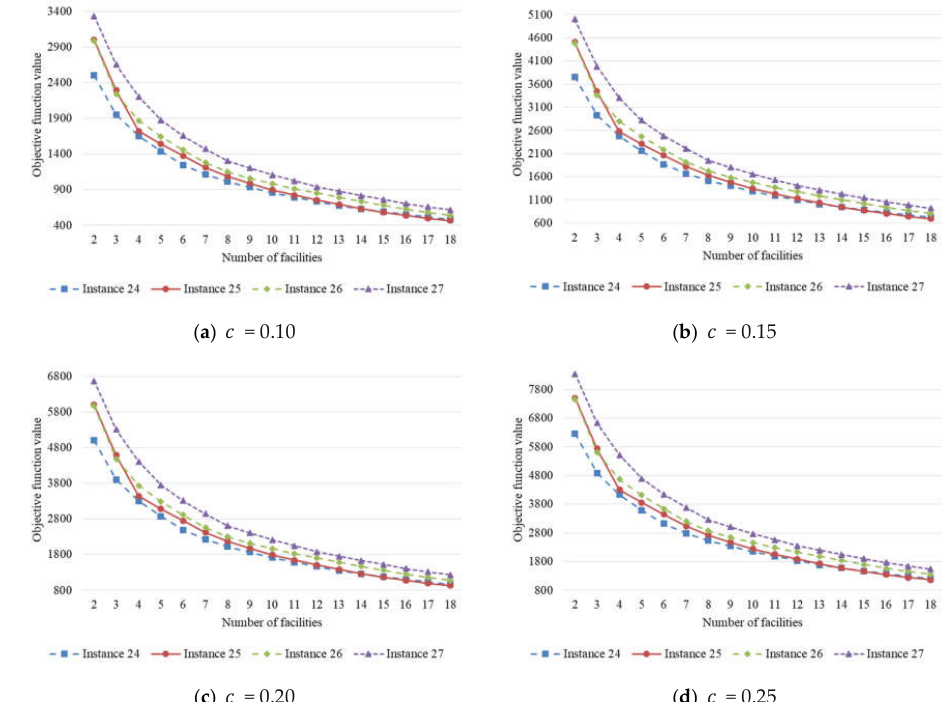
Figure 8. Relationship between the number of facility and objective function value in model ℳ1. ( a ) c = 0.10; ( b ) c = 0.15; ( c ) c = 0.20; ( d ) c = 0.25.